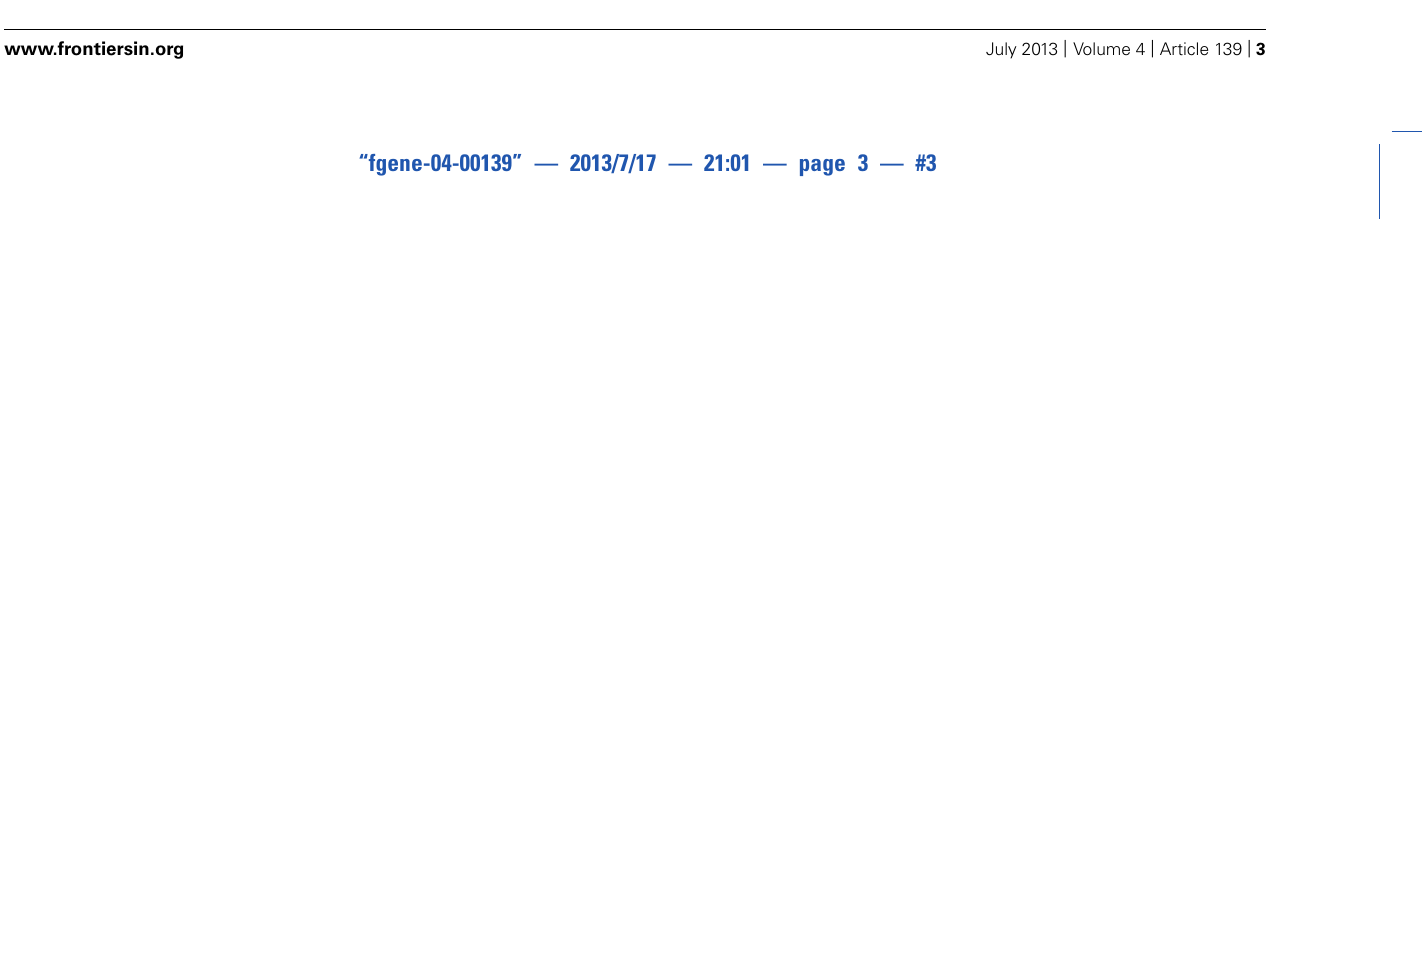
FIGURE 1 | Potential distribution of DNA damage associated modifications around nascent DSBs. (A) When a DSB occurs on a chromosome y, aside from the confirmed linear phosphorylation in the vicinity of the break site along the chromosome y (a), H2AX could be phosphorylated on distal chromosomal regions of the same chromosome (b), or on regions of different chromosomes (chromosomes x, z) in the vicinity of the break site (c).